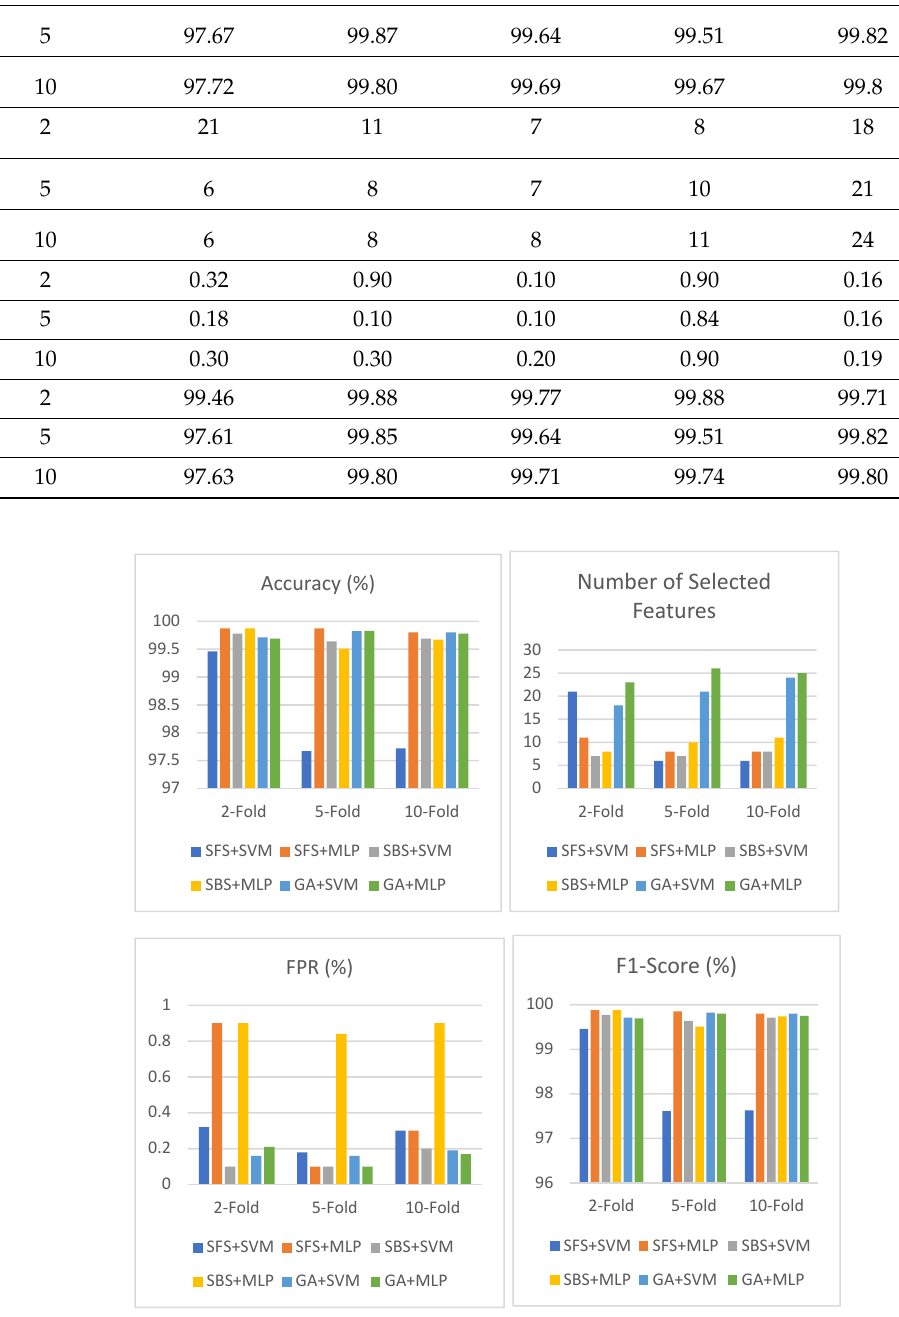
Figure 8. Performance of SFS, SBS, and GA using objective function based on accuracy and number of selected features in CIC-IDS-2018.